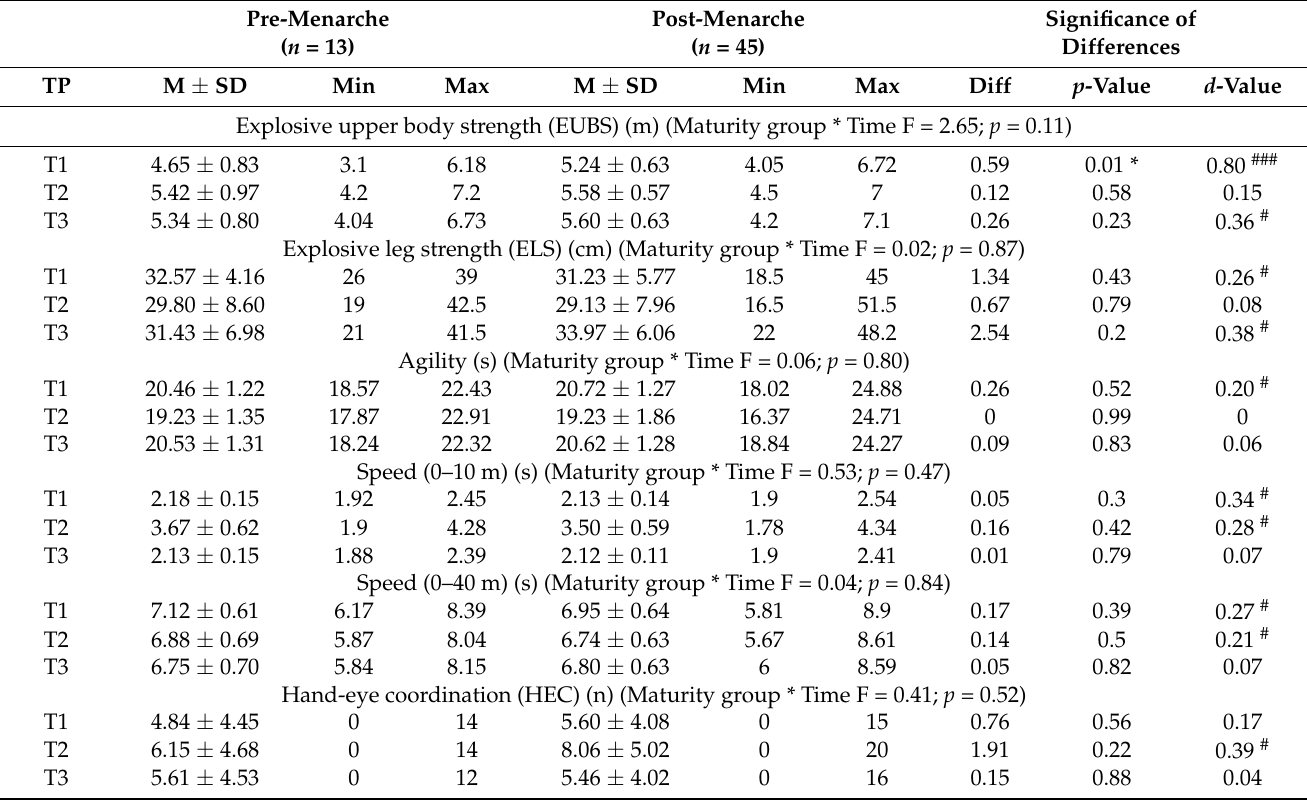
Post-Menarche ( n = 45)